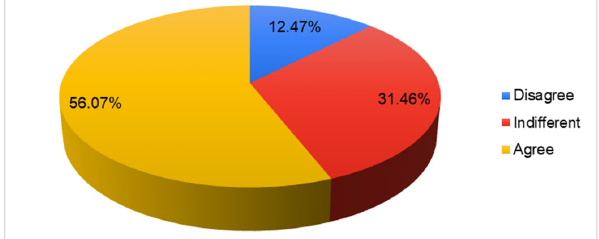
Fig. 2. Level of agreement (concordance) of university students in the use of the virtual classroom for pandemic Covid19 of FATS - UNCP in the academic period 2021-II